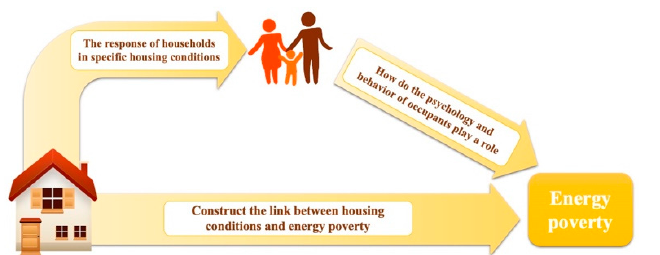
Figure 1. Direct and indirect links between housing conditions and energy poverty.